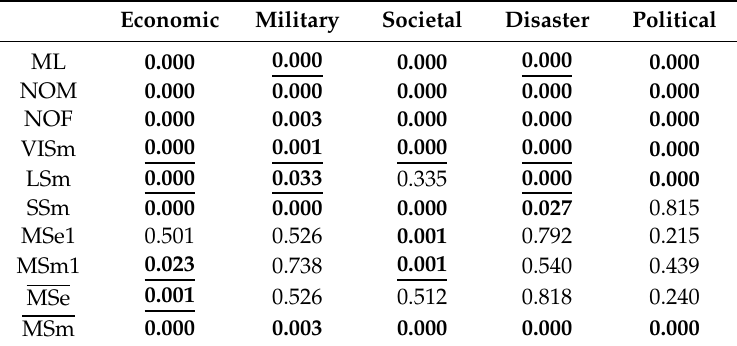
Figure 5. Feature importance in the different categories. Table 4. T -test results for the rumor refuters and stiflers.